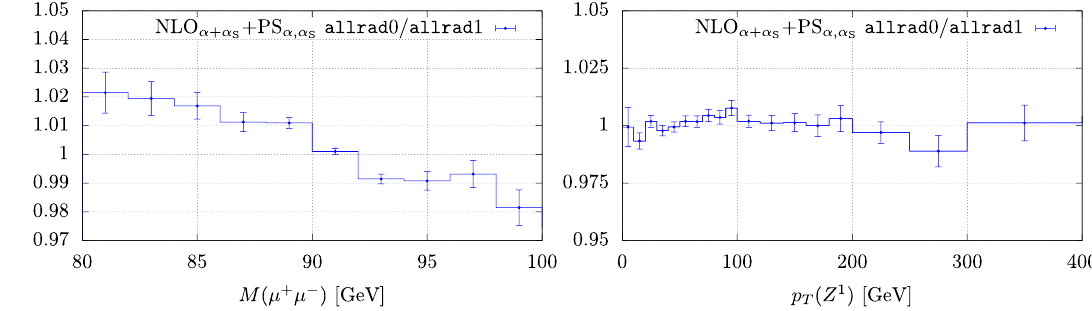
Fig. 7 Ratio of the predictions at NLO QCD + NLO EW + PS QCD , QED accuracy computed with and without the allrad option ( allrad 1 and allrad 0, respectively) for the invariant mass of the dimuon pair and the transverse momentum of the hardest Z in pp → e + e − μ + μ − . See main text for